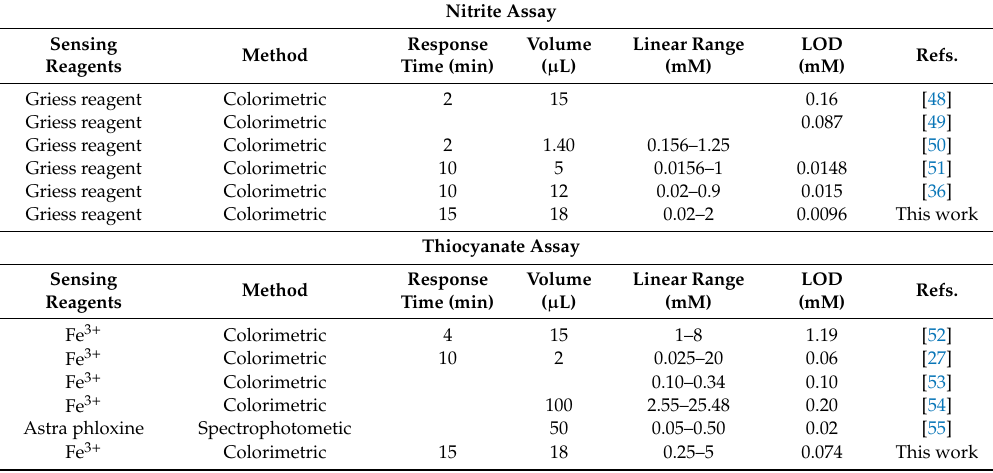
Figure 8. Assay results for nitrite ( A ) and thiocyanate ( B ) based on the developed 3D sl- µ PADs. Table 1. A contrast of the assay performance between our 3D sl- µ PADs and other sensors reported by other groups in the determination of nitrite and thiocyanate.